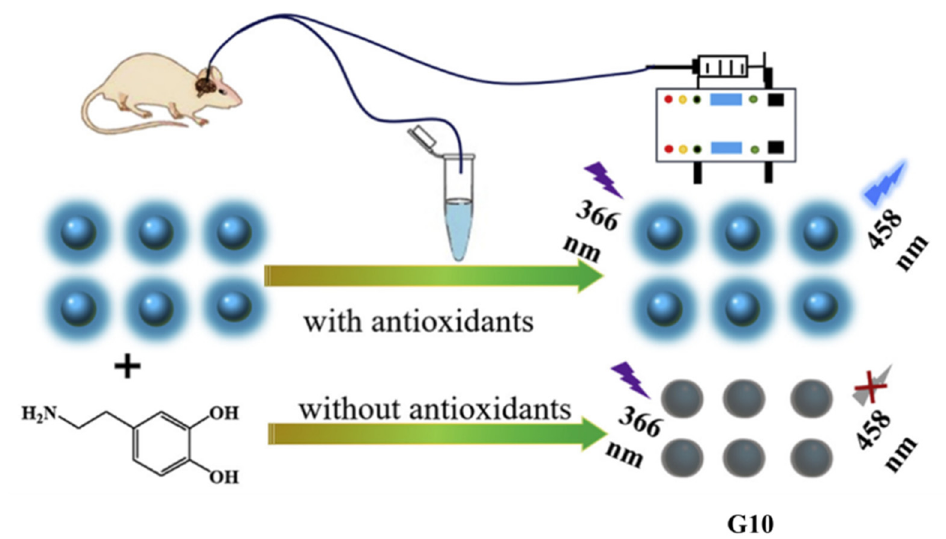
Figure 12. Schematic diagrams for the detection of antioxidants using GQDs@PDA ( G10 ). Reprinted from [67] with the permission from Elsevier.